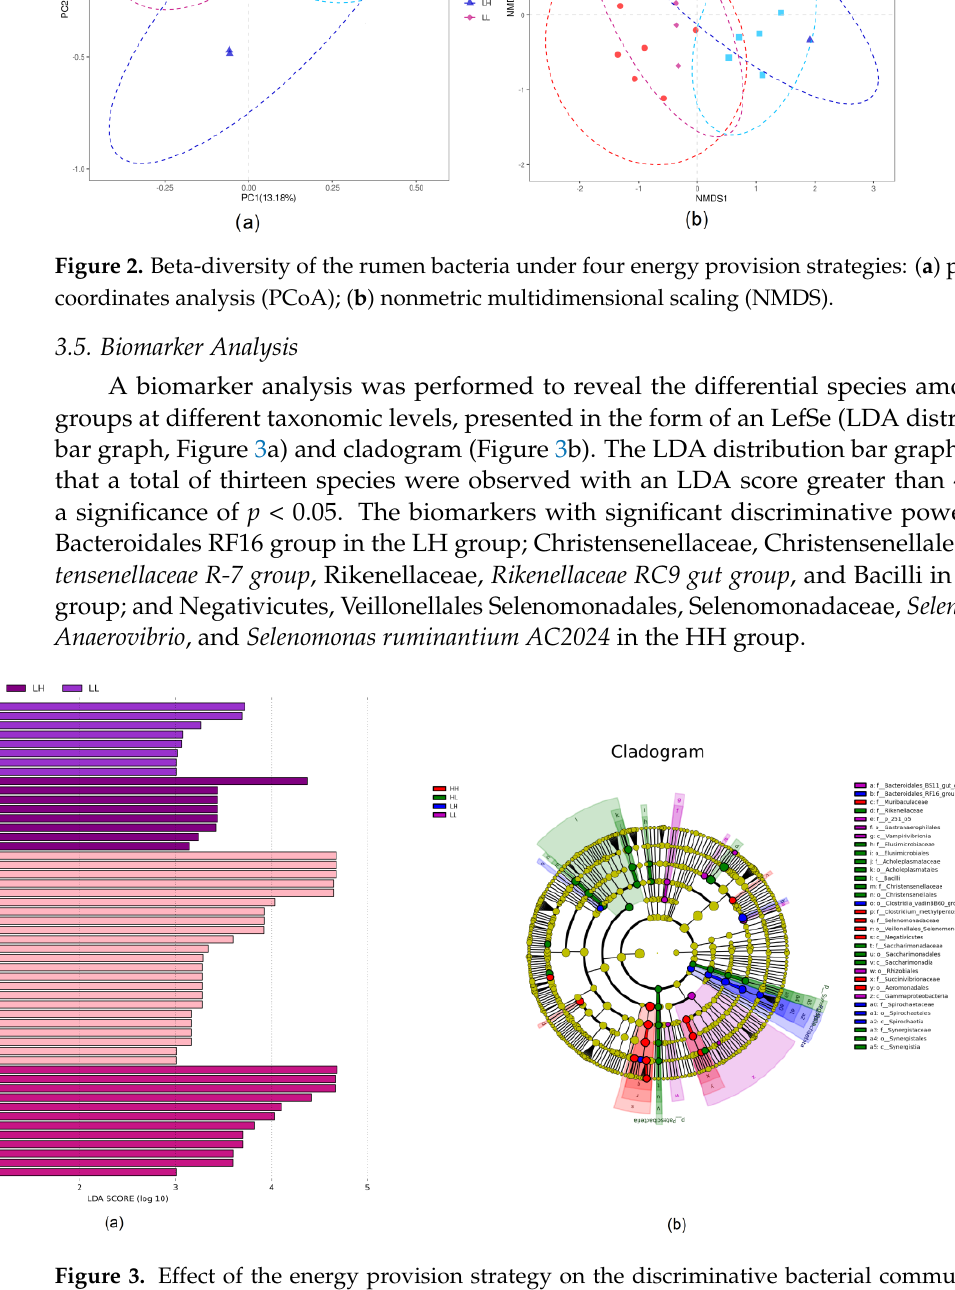
Figure 3. Effect of the energy provision strategy on the discriminative bacterial communities at different taxonomic levels: ( a ) linear discriminant analysis (LDA) score generated from the LEfSe analysis; ( b ) cladogram derived from the LEfSe analysis.